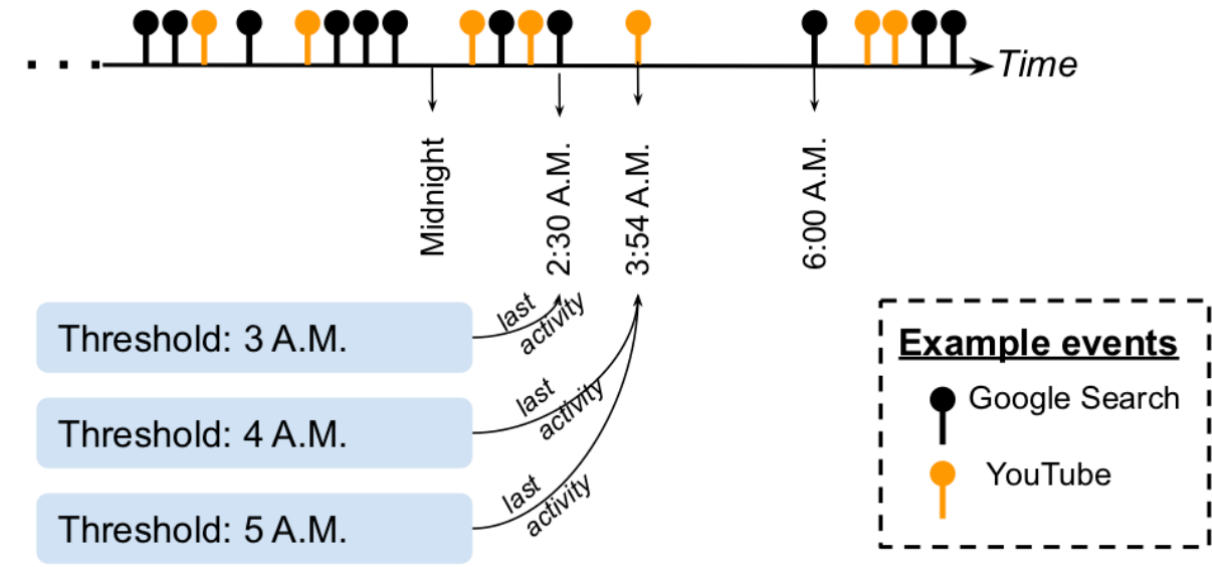
Figure 3. An example to demonstrate how the last seen activities are selected for different threshold